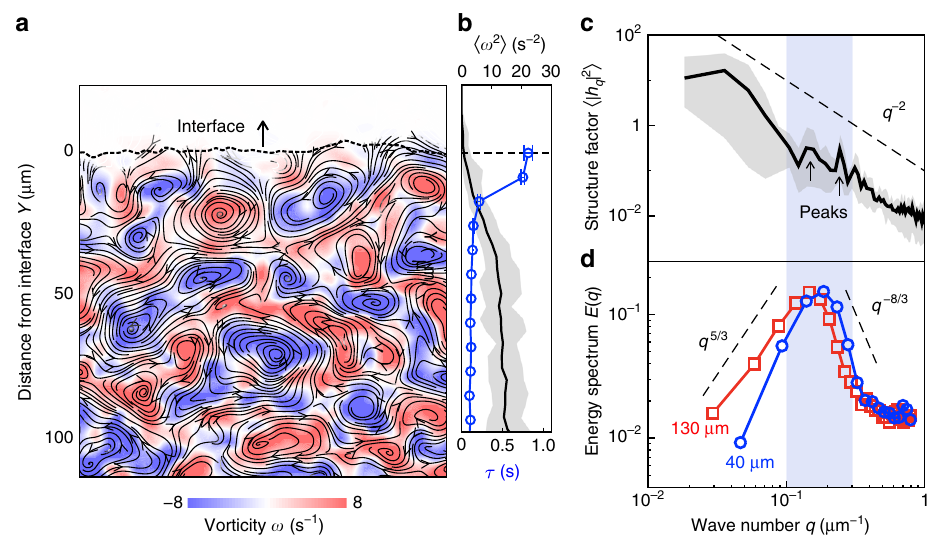
Fig. 3 Interface structure is coupled to collective fl ow of bacteria. a A snapshot of the bacterial vorticity fi eld, t = 4 s after exposure with the half-space (H) aperture. b The strength of the vorticity fi eld, characterized by 〈 ω 2 〉 , increases as one moves away from the interface boundary; while the fl ow decay timescale τ decreases (blue error bars represent standard error and gray variation represents min to max values gathered from temporal fl uctuations in a (cid:3) (cid:3) (cid:3) (cid:3) 2 (cid:1) q (cid:3) 2 , yielding an interfacial stiffness κ = 0.7 μ m − 2 . representative experiment). c The overall decay of the interface static structure factor scales as Δ h q The black line represents the averaged results of N = 4 experiments for the half-plane aperture geometry; gray variation represents min to max. d The energy spectrum of the fl ow E ( q ) (Eq. (9)) is non-monotonic with a peak that shifts to higher values of q close to the interface ( Y ≈ 40 μ m) compared with the bulk active phase ( Y ≈ 130 μ m); data averaged over 10 s from a representative sample. The peak in E ( q ) coincides with peaks in j Δ h 2 q